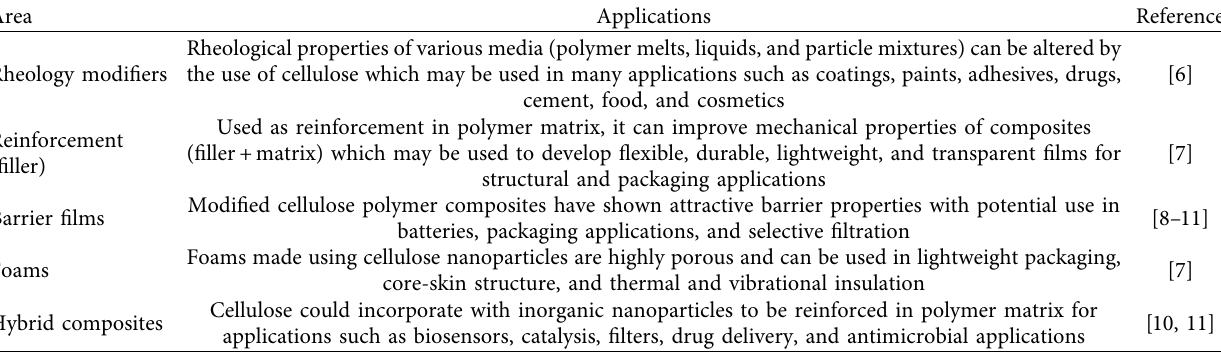
Table 1: Applications of cellulose